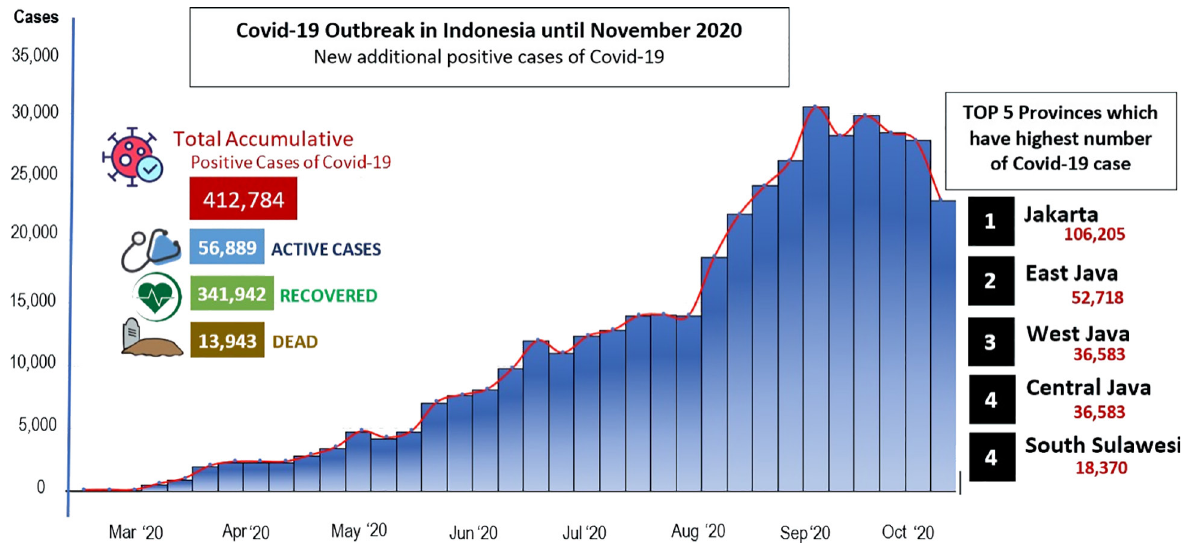
Fig. 1. The COVID-19 outbreak in Indonesia (COVID-19 Response Acceleration Task Force